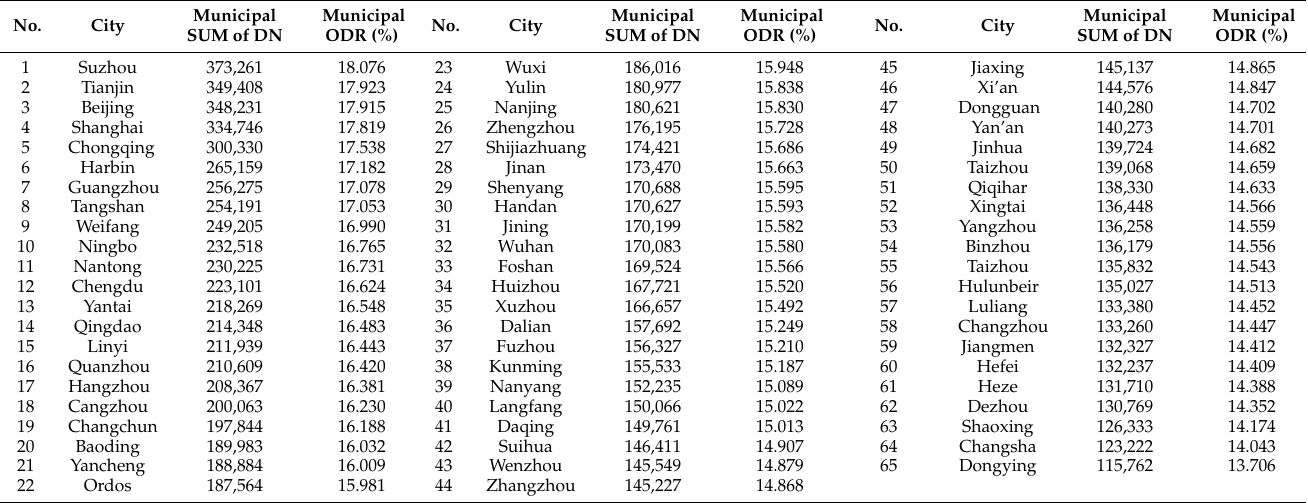
Table 4. Prediction results of the municipal ODR in large and medium-sized cities in